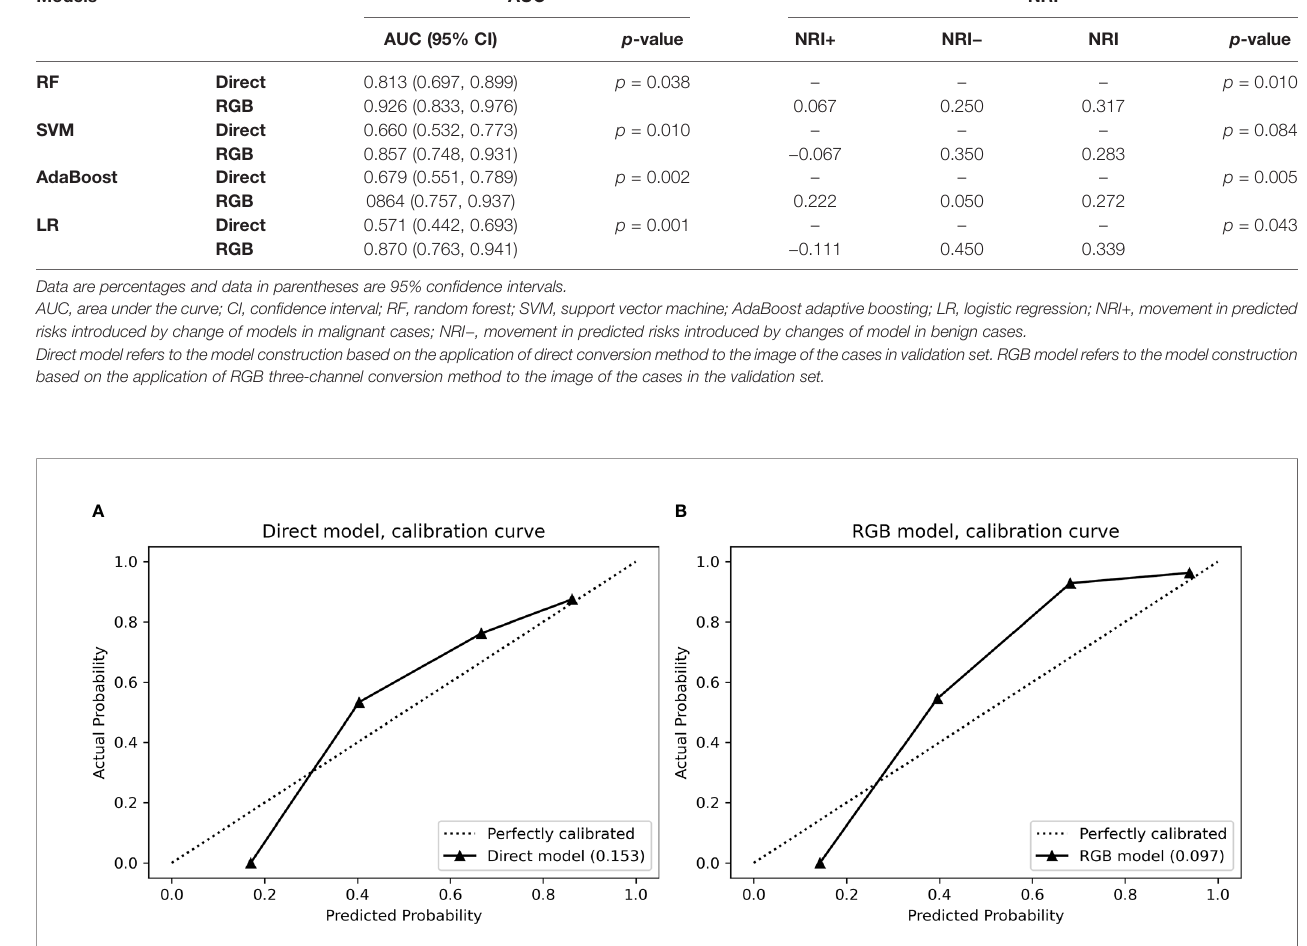
TABLE 3 | Evaluation the performance of direct model and RGB model of the validation cohort.